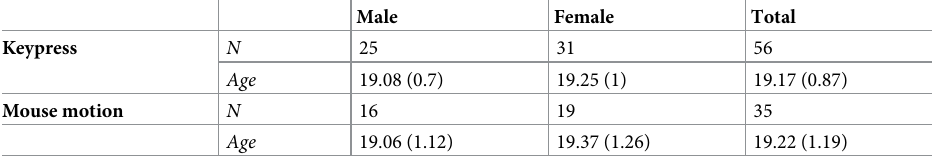
Table 1. Participants’ demographic